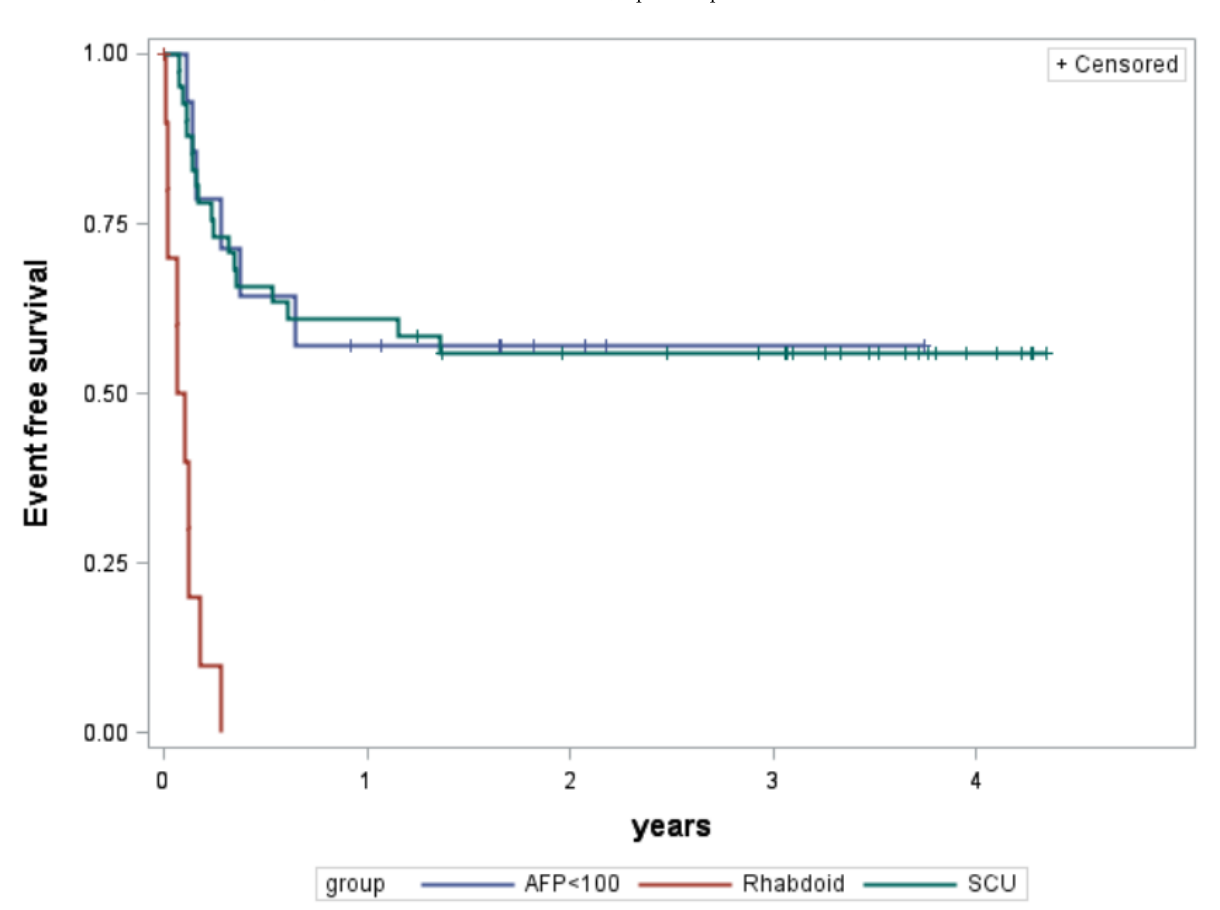
Figure 2. Event-free survival in years by group. AFP, alpha-fetoprotein; HB, hepatoblastoma.